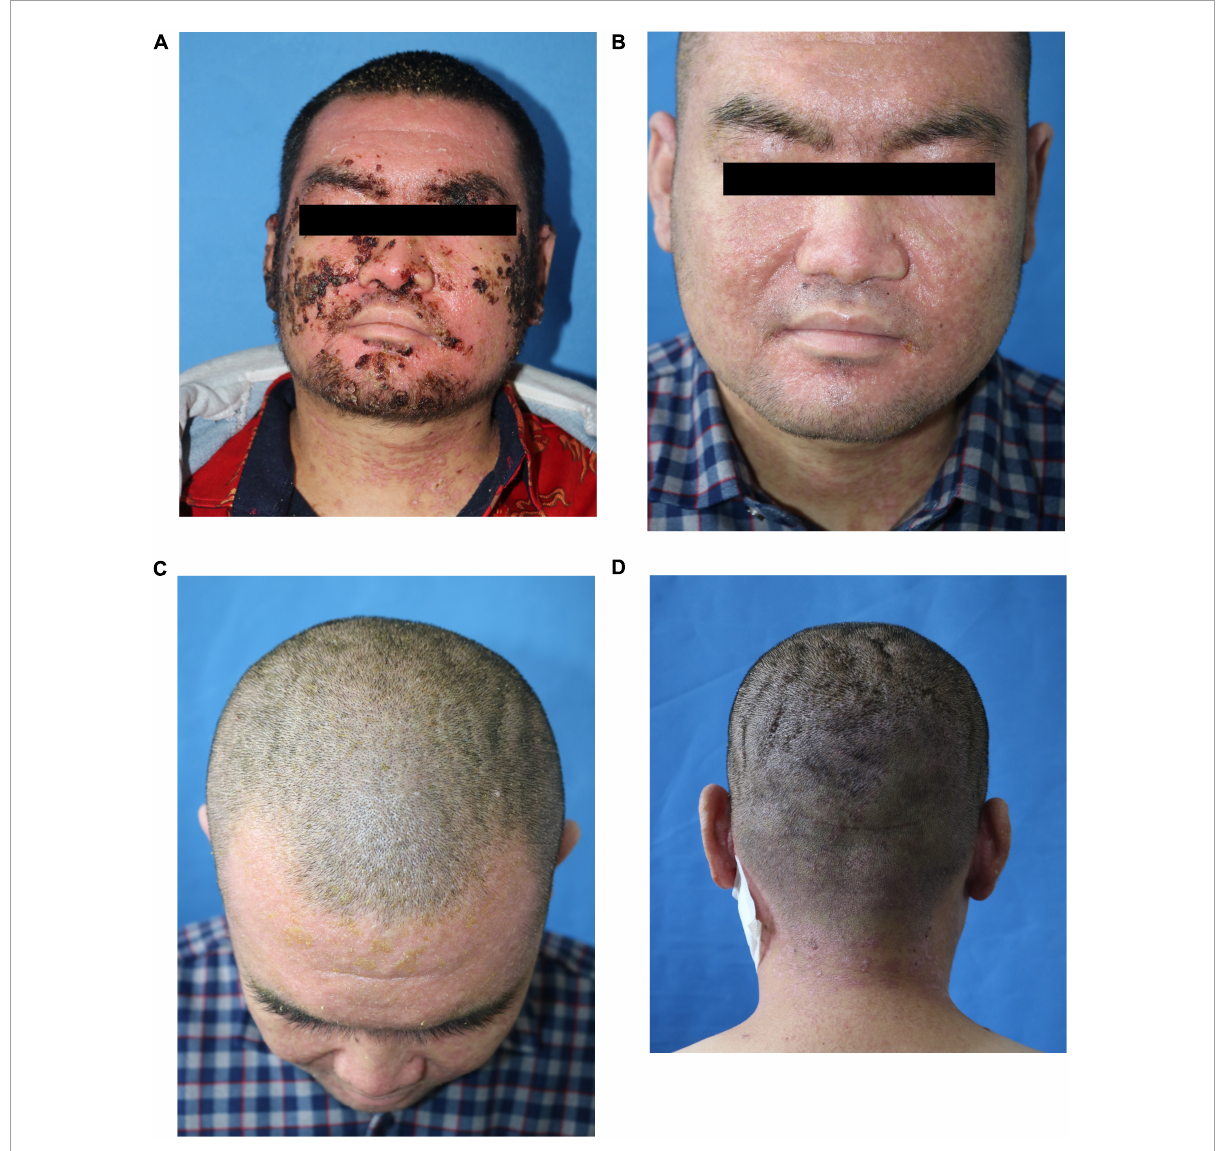
FIGURE3 Clinical pictures after treatment. (A) Three days after treatment; (B–D) the scalp was furrowed before